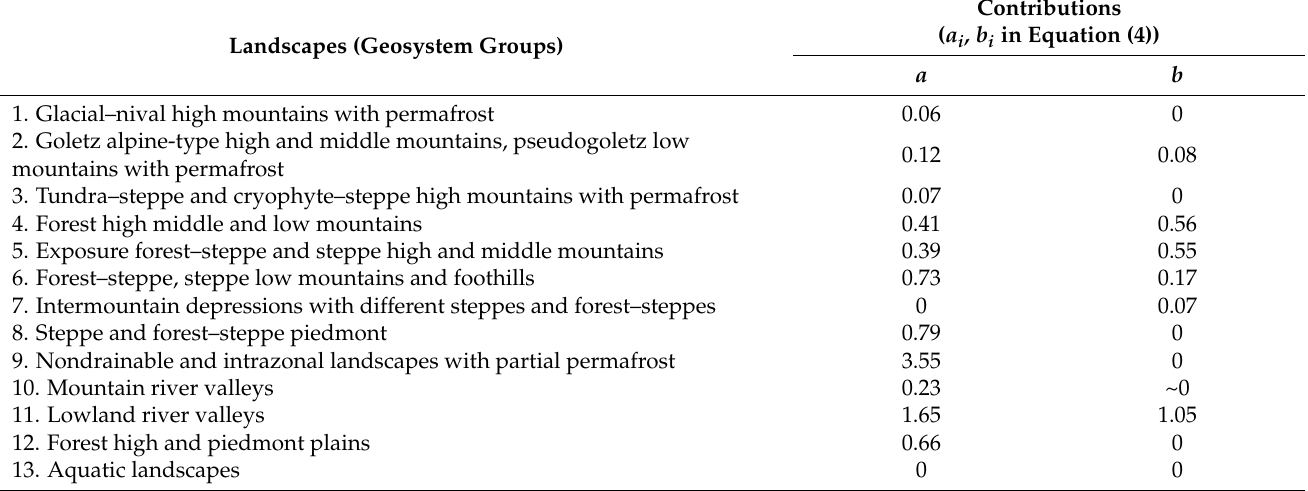
Table 2. Contributions of landscapes to April monthly flood on rivers of the Altai-Sayan moun- tain